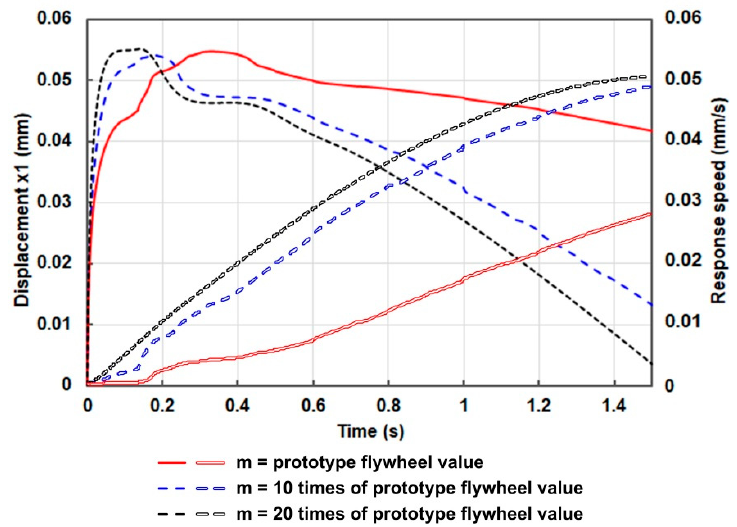
Figure 10. Displacement and speed response of the A-HMB system with the mass parameter variation.